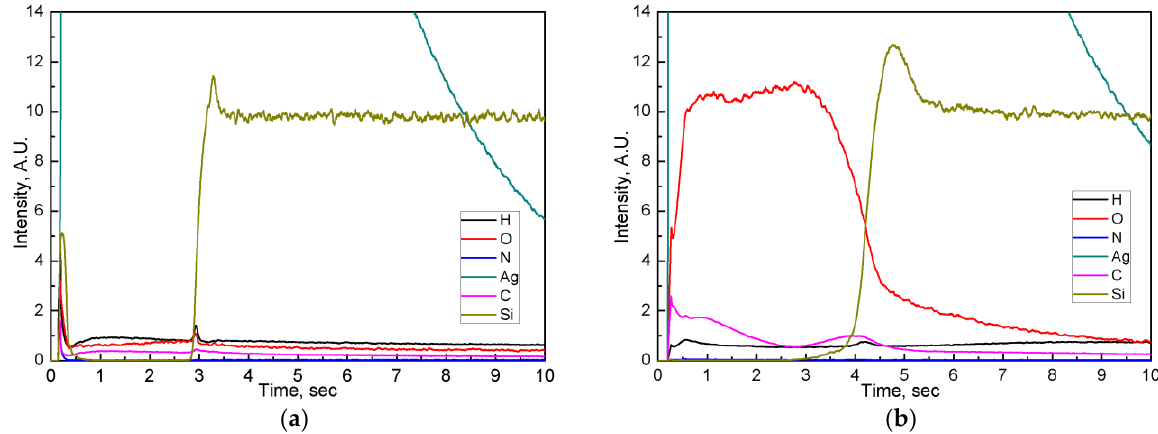
Figure 8. GD-OES profiles of elements: ( a ) non-treated in O 2 plasma SiN x /Ag mirror with an 1.5 nm SiN x protection layer; ( b ) treated with O 2 plasma for one minute.